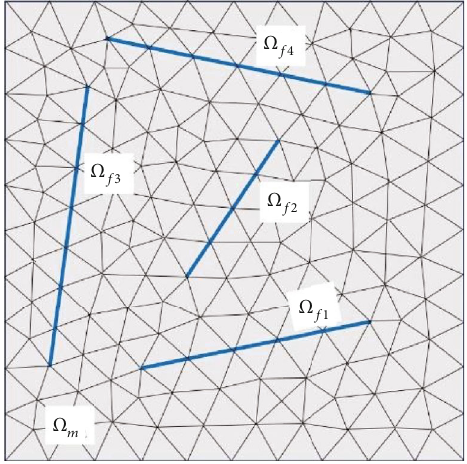
Figure 1: Schematic of the matrix Ω